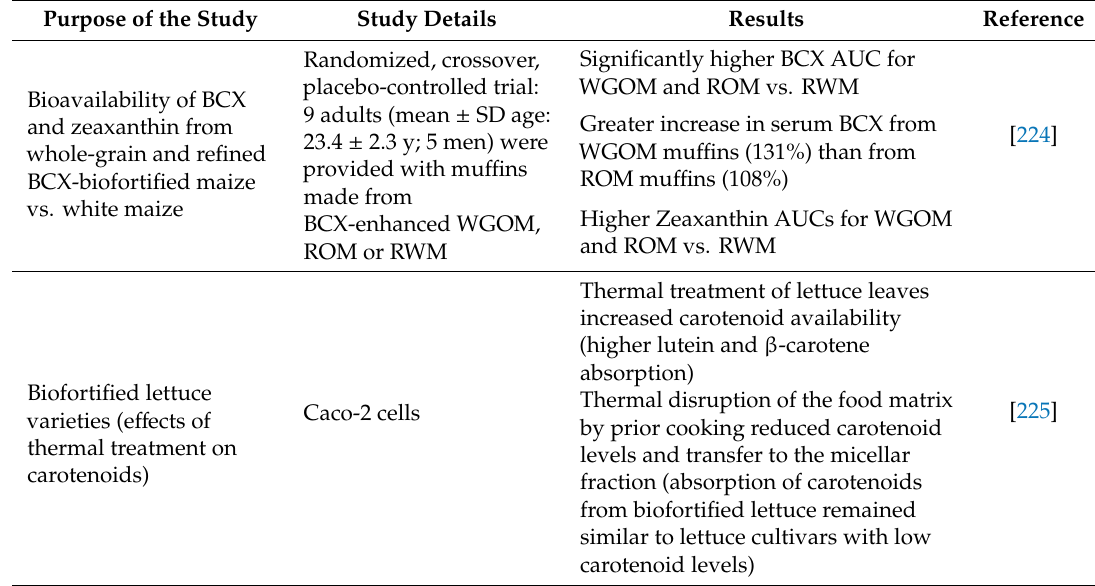
Table 5. The impact of biofortification on the content and bioavailability of carotenoids.